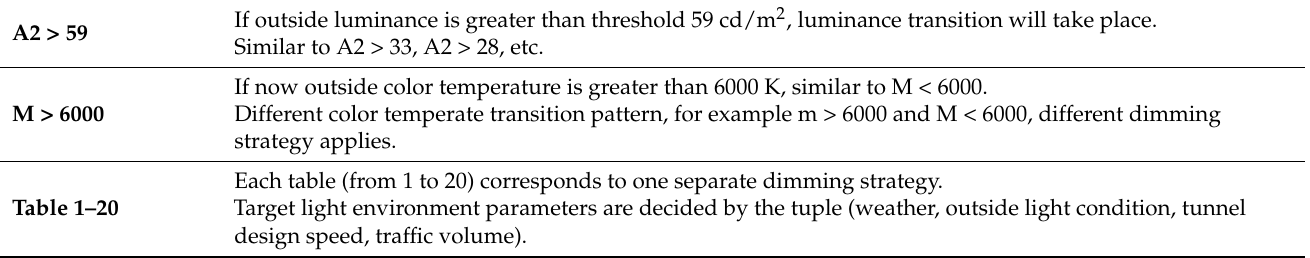
Each table (from 1 to 20) corresponds to one separate dimming strategy. Target light environment parameters are decided by the tuple (weather, outside light condition, tunnel design speed, traffic